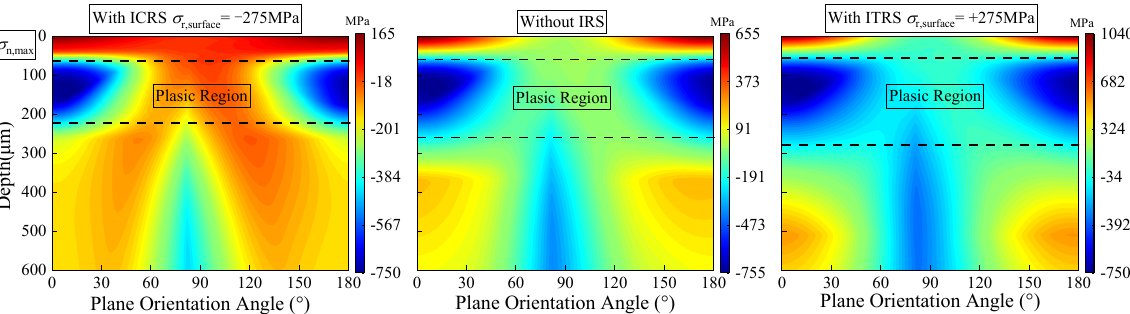
Figure 22. The effect of residual stress on the plastic region scope ( T out = 2000 N m, P h = 2.47 GPa).